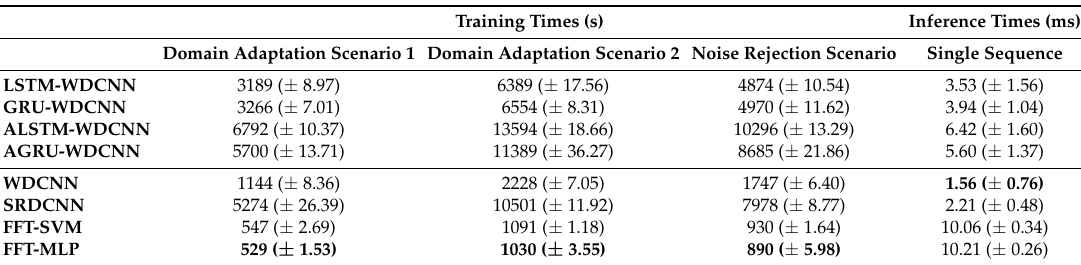
Table 16. Time costs for training and inference of the models considered in this work (best values are highlighted in bold). Note that the top four models in this table are the variants of RNN-WDCNN considered in the initial experiments in Sections 4.2 and